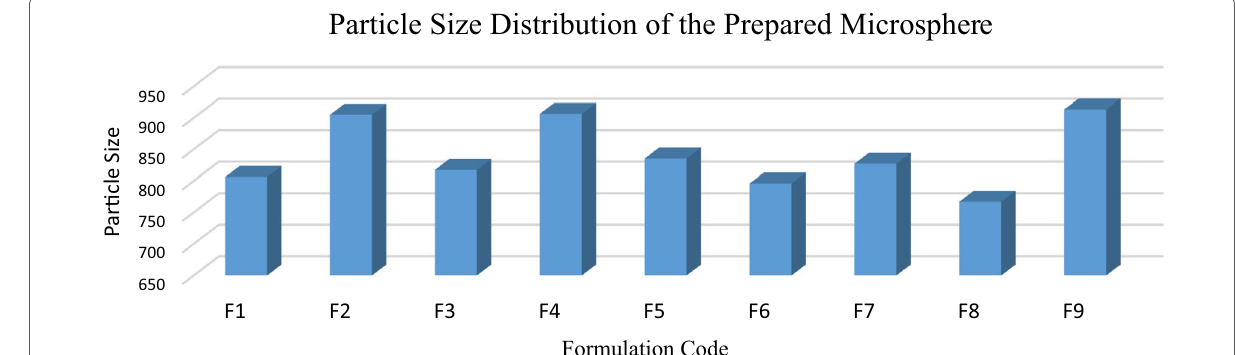
Fig. 12 The particle size distribution of the prepared batches of microspheres. The enhancement of the size of microspheres can be related to the growth in viscosity of the polymeric solution as the concentration was elevated. This elevation in viscosity, in turn, increases the droplet size when the polymer-drug mixture was added to the cross-linking solution, thereby resulting in a larger size of particles. Moreover, as the concentration of the cross-linking agent (CaCl 2 ) was increased; a gradual decrease in the size of the microsphere was